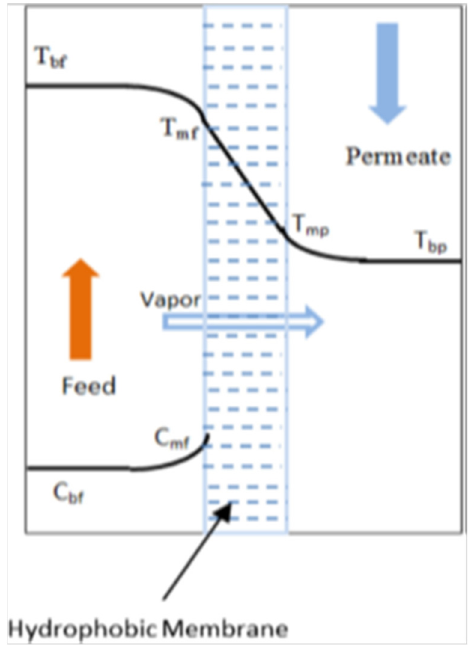
Fig. 1. DCMD process with concentration and temperature